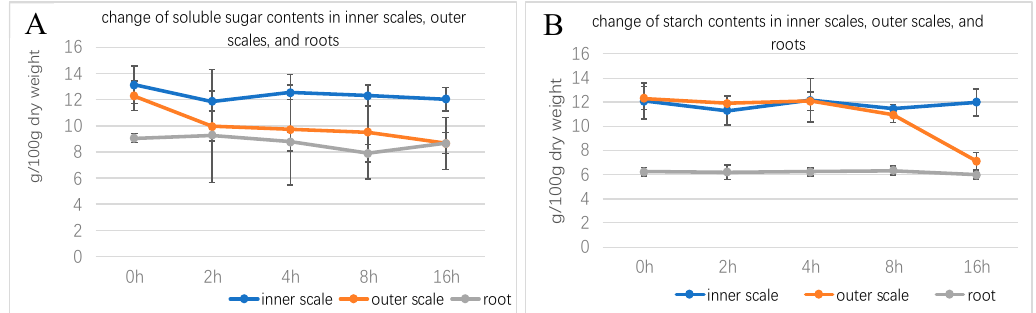
Figure 3. Changes of soluble sugar and starch contents in different tissue parts during the exogenous GA 3 treatment. ( A ) Comparison of soluble sugar contents in inner scales, outer scales, and roots. ( B ) Comparison of starch contents in inner scales, outer scales, and roots.